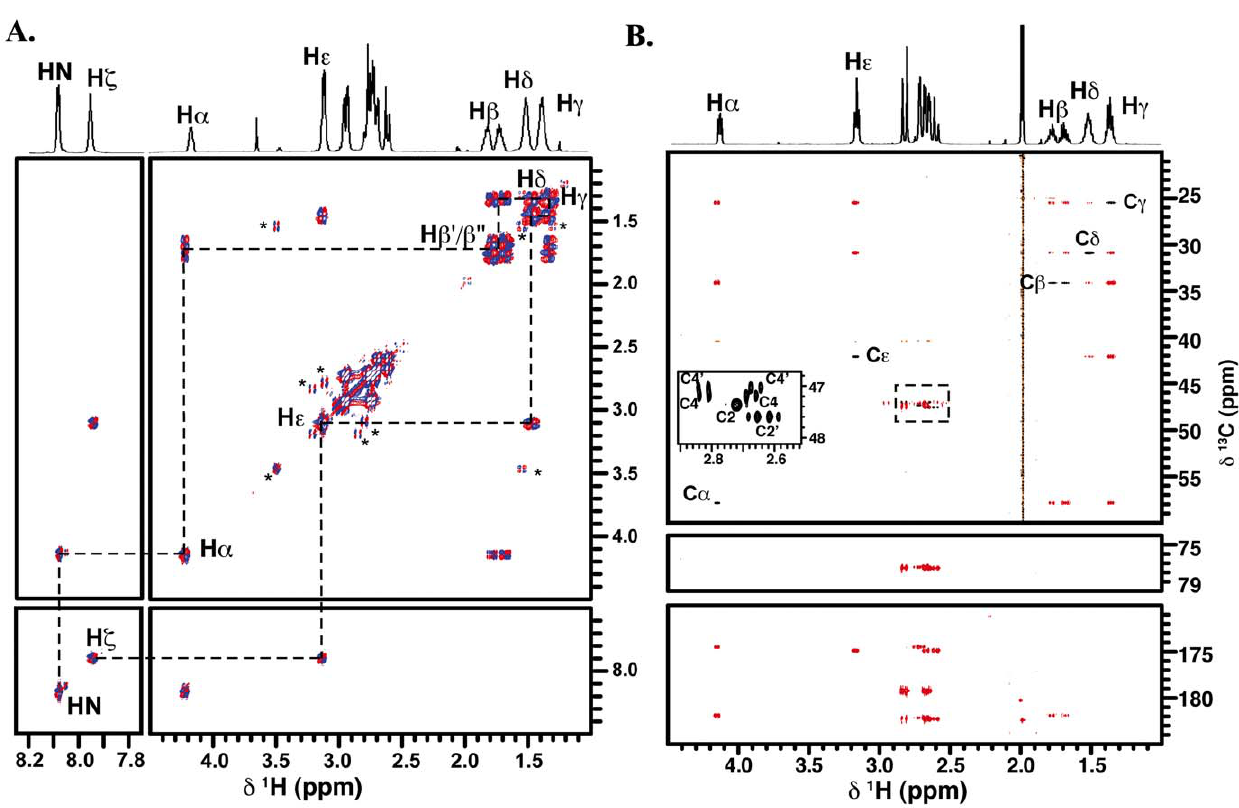
Figure 4. Analysis of corynebactin structure by NMR spectroscopy. A. 1 H- 1 H DQF-COSY spectrum of corynebactin dissolved in 90% H 2 O at pH 4.0. Dashed lines illustrate the correlations between the protons in the central lysine core moiety B. Overlay of the 1 H- 13 C HSQC Spectrum of corynebactin dissolved in D 2 O at pH 6.0 (black) with the 1 H- 13 C HMBC (red). The inset shows an expansion of the region indicated by the dashed box.